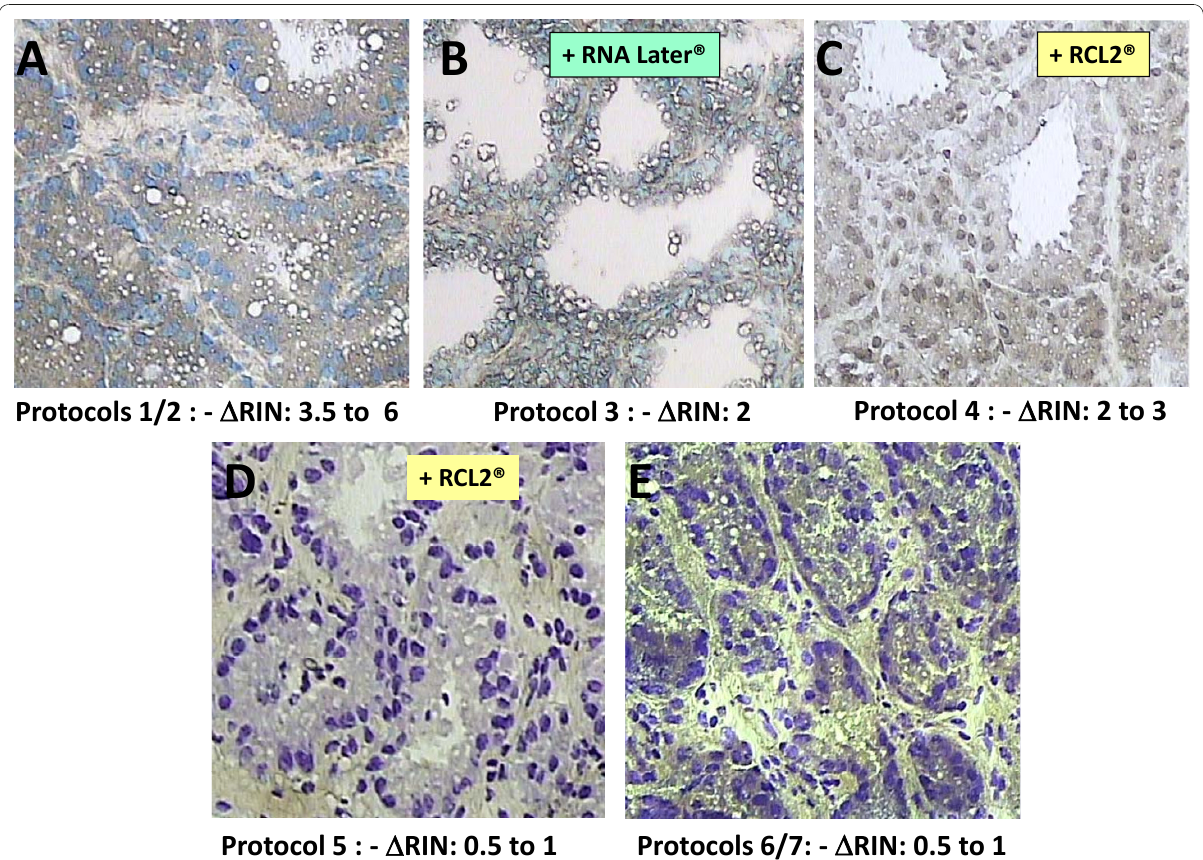
Figure 3 Impact of histological stain and fixative/protector on morphology of goat mammary tissue and RNA integrity . Frozen mammary tissue sections were stained either with HistoGene® (A to C) or with Cresyl violet® (D and E). MEC isolated after treatment with RCL2, a new fixative preserving tissue morphology and Nucleic Acid integrity (C and D), or with RNA later (B) provide RNA of better quality, expressed as Δ RIN which is difference between the RIN value obtained with total RNA extracted from the mammary tissue section (8.5) and the RIN value obtained with RNA extracted from microdissected